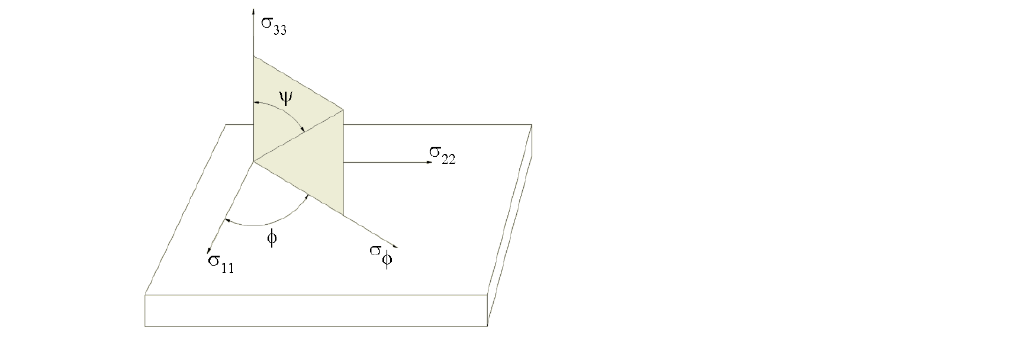
Figure 6. Plane-stress elastic model: σ 11 , σ 22 , σ 33 —normal stresses, σ Φ —stress component in measured direction, ψ —angle of diffracting crystallographic planes.